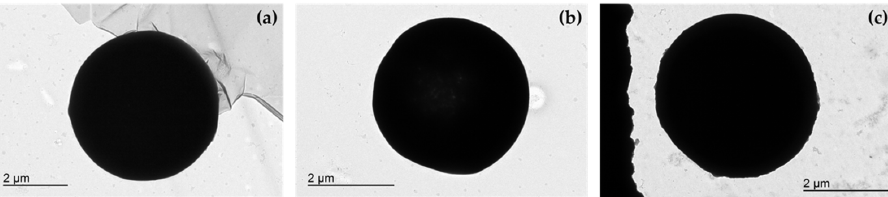
Figure 3. TEM images of CMC ‐ Na microcapsules containing BTA obtained by spray drying with different experimental conditions: ( a ) condition 1: 170 °C and 440 L/h; ( b ) condition 3: 180 °C and 440 L/h; and ( c ) condition 5: 190 °C and 440 L/h.